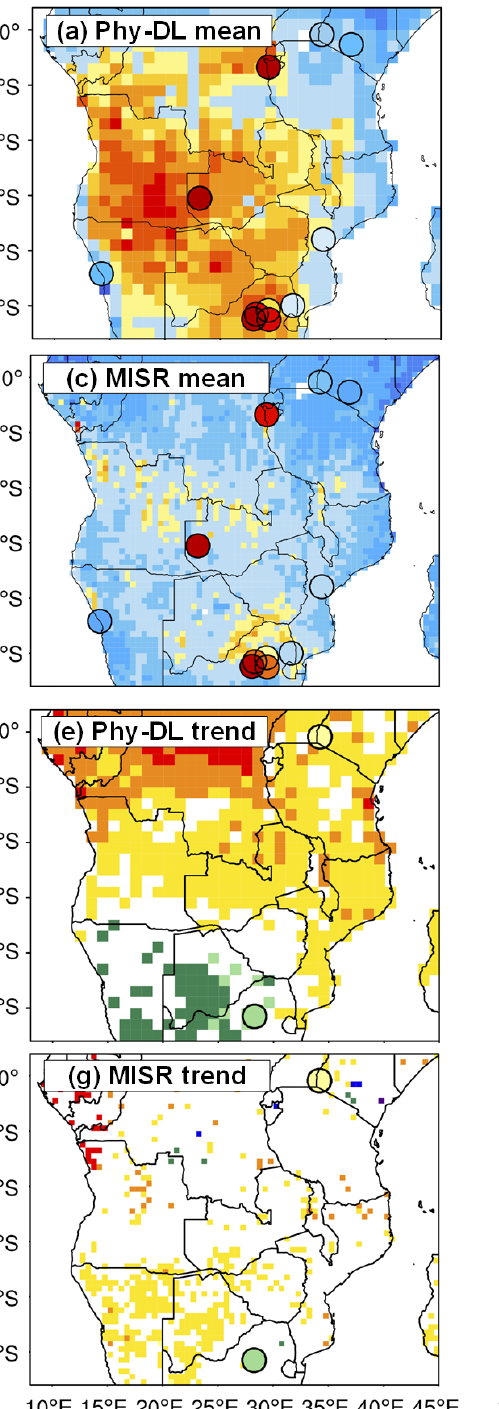
Earth Syst. Sci. Data, 14, 1193–1213,